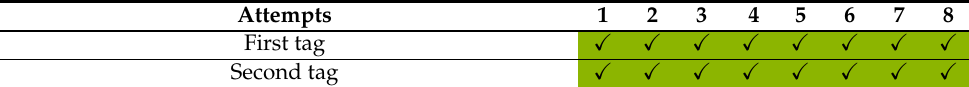
Table 7. Two tags; one enters; one outside repeatability test results.